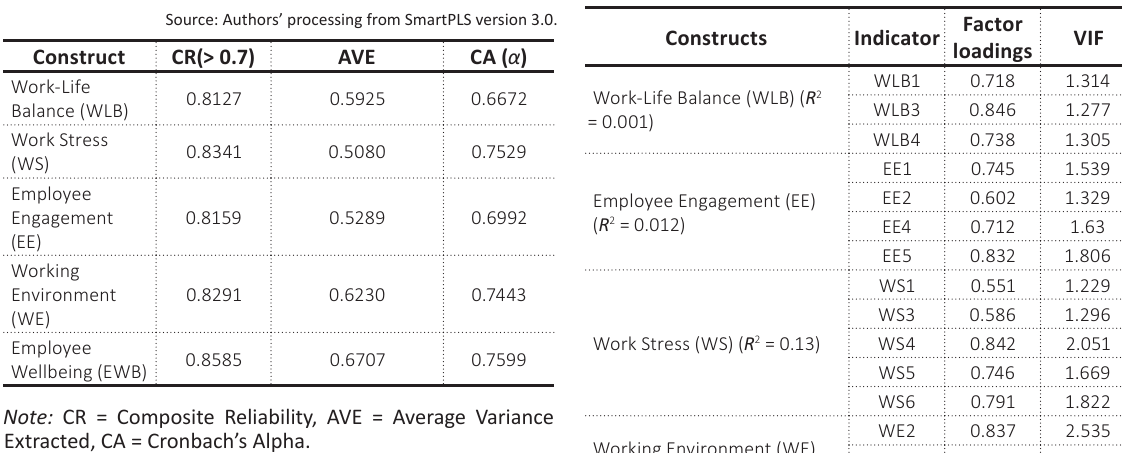
Table 3. Measurement model for